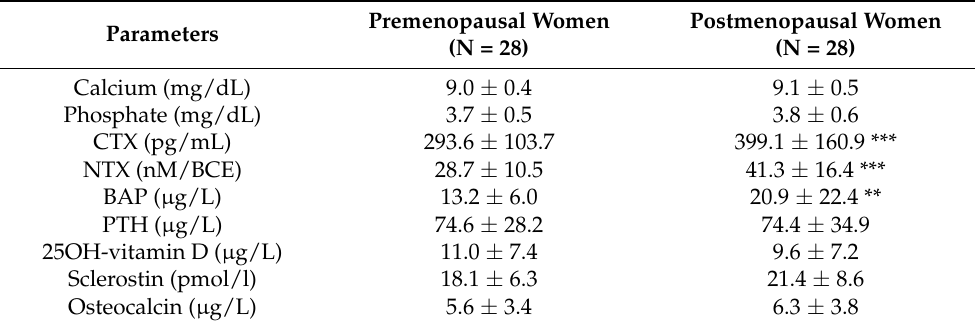
Table 2. Bone-related biochemical and hormone parameters measured in the study groups. Signifi- cance was calculated by two-tailed unpaired Student t test. For significance: ** p < 0.01; *** p < 0.001. Parameters (N = 28) Calcium (mg/dL)